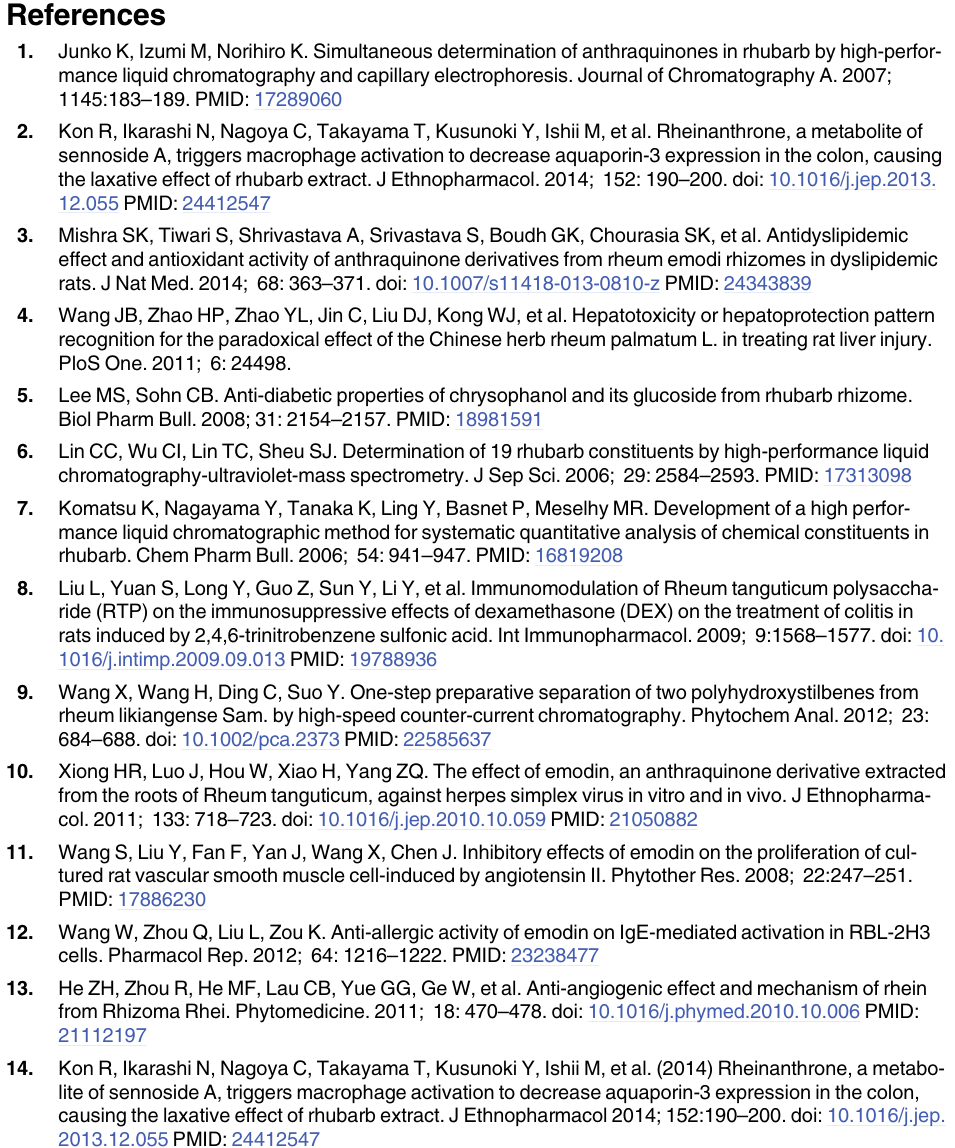
S2 Table. Calibration curves of the five biological active ingredients.